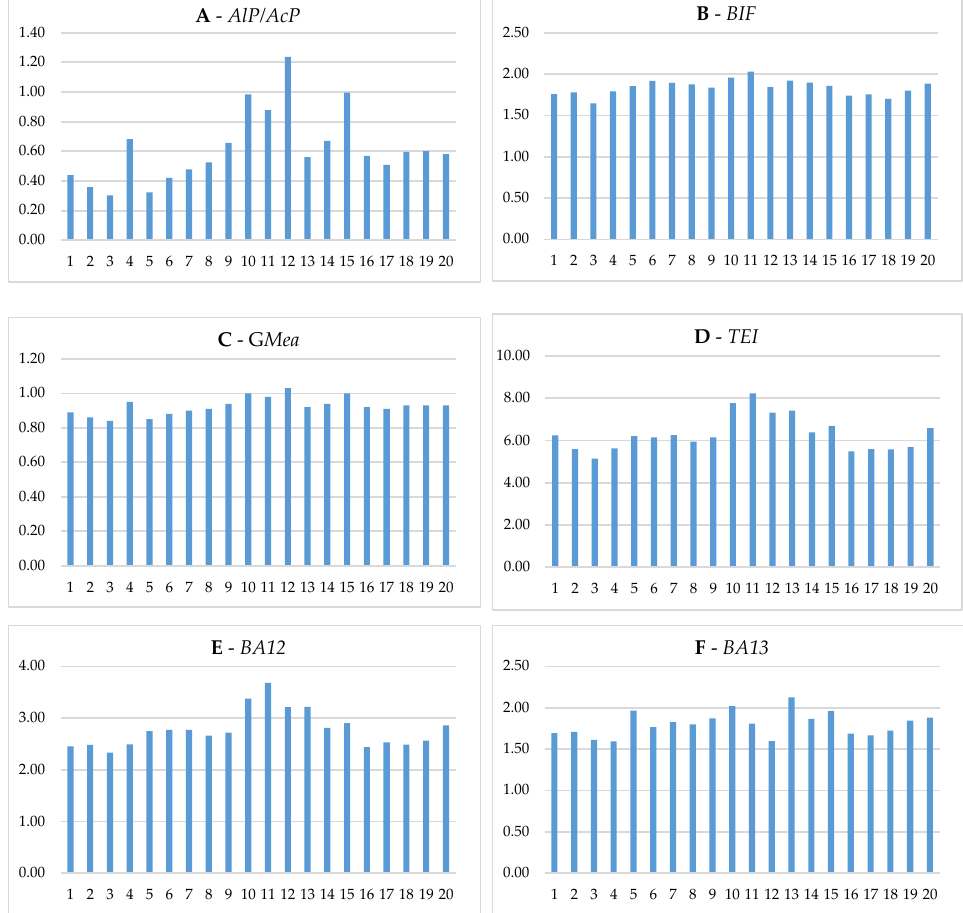
Figure 2. ( A – F ) Enzymatic indices of soil quality. ( A ) AlP/AcP —enzymatic index of soil pH level; ( B ) BIF —biological index of fertility; ( C ) G Mea —geometric mean; ( D ) TEI —total enzyme activity index; ( E ) BA12 and ( F ) BA13 —indices of biochemical soil